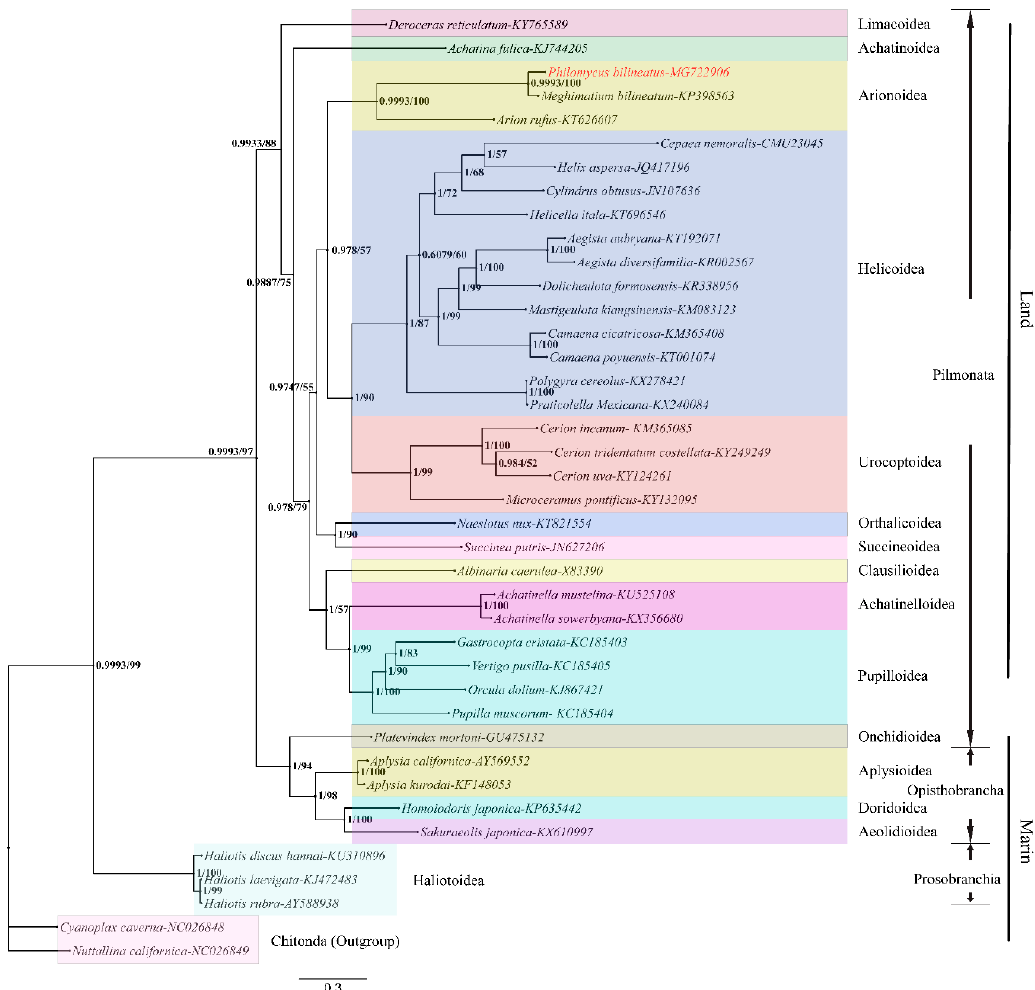
Figure 7. Phylogeny of P. bilineatus . The phylogenetic tree was inferred from the amino acid sequences of the 13 PCGs in the mitogenome. The numbers on the branches indicate the posterior probabilities (BI/ML). Chitonida species ( C. cavema and N. californica ) were used as the outgroups. Different colors represent different superfamilies.